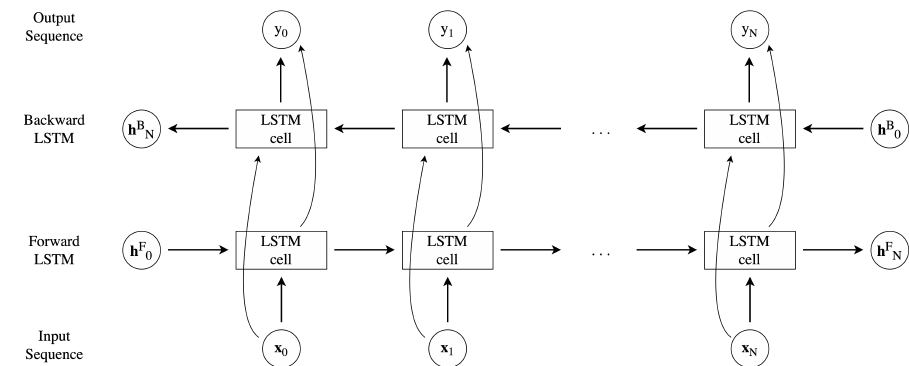
Figure 7. Unrolled network structure of a bidirectional